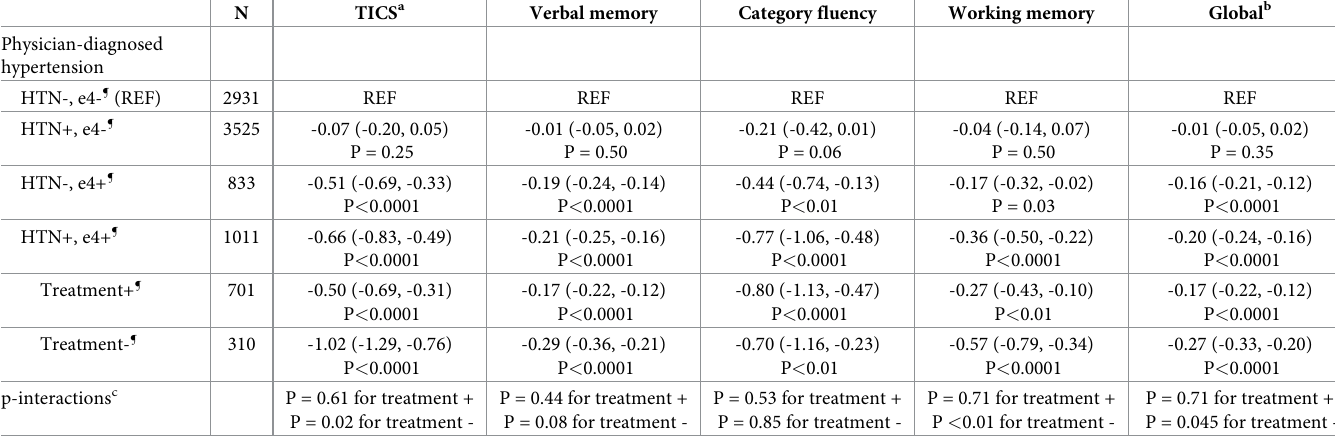
Table 3. Multivariable-adjusted � mean differences (95% CI) in average cognitive performance in up to 4 assessments (1995–2008), by APOE e4 status an history of physician-diagnosed hypertension (n = 8300; 1995–2008), with and without treatment. N TICS